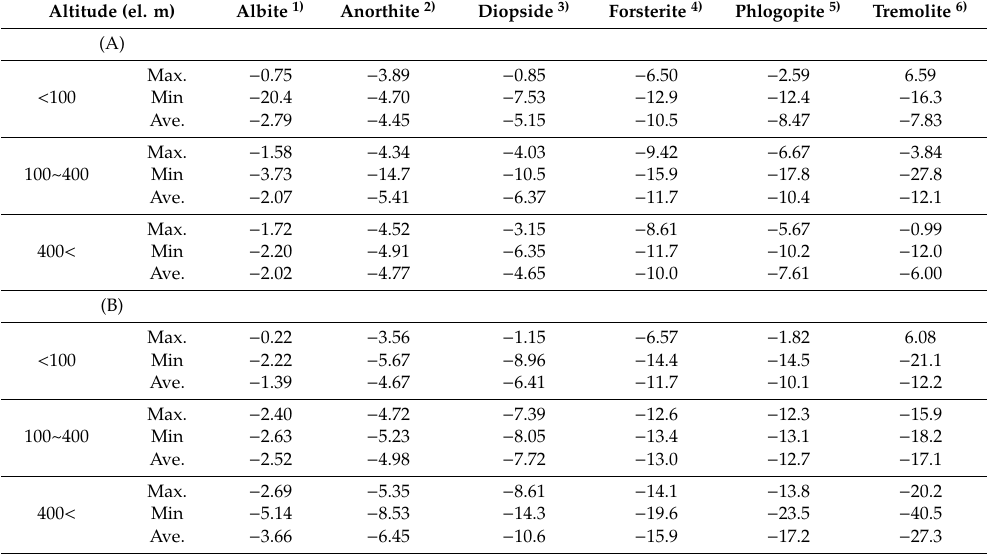
Table 5. Statistical saturation indices of chemical composition of groundwater (A) and spring water (B) with respect to major reactive minerals in Jeju